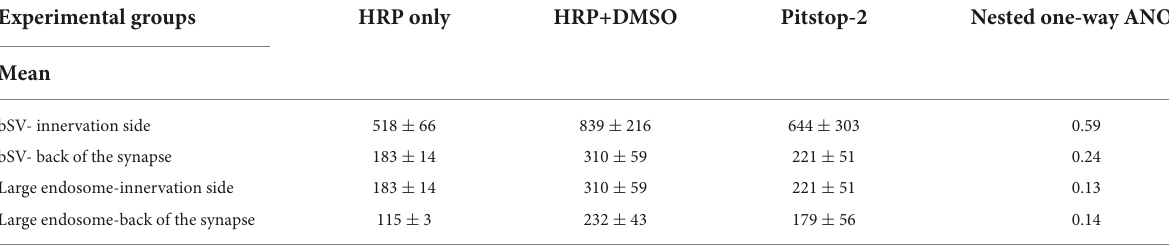
TABLE 1 Distance measurements between endocytic structures and the PM at either the innervation side or the back of the synapse. Experimental